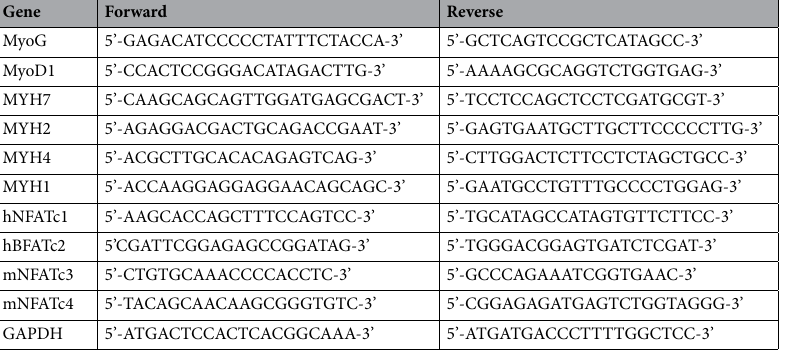
Table 1. The sequences of primers of